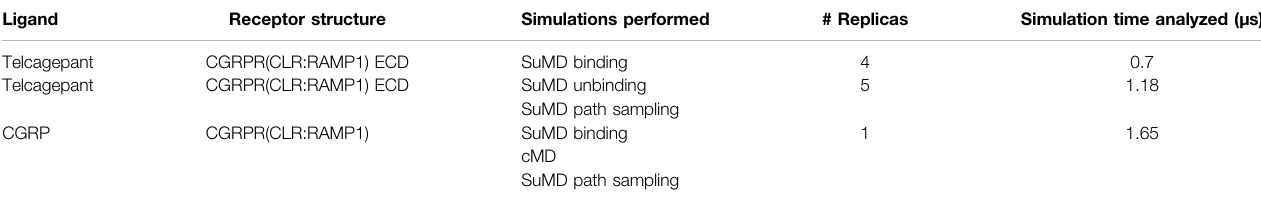
TABLE 1 | Summary of the MD simulations performed and